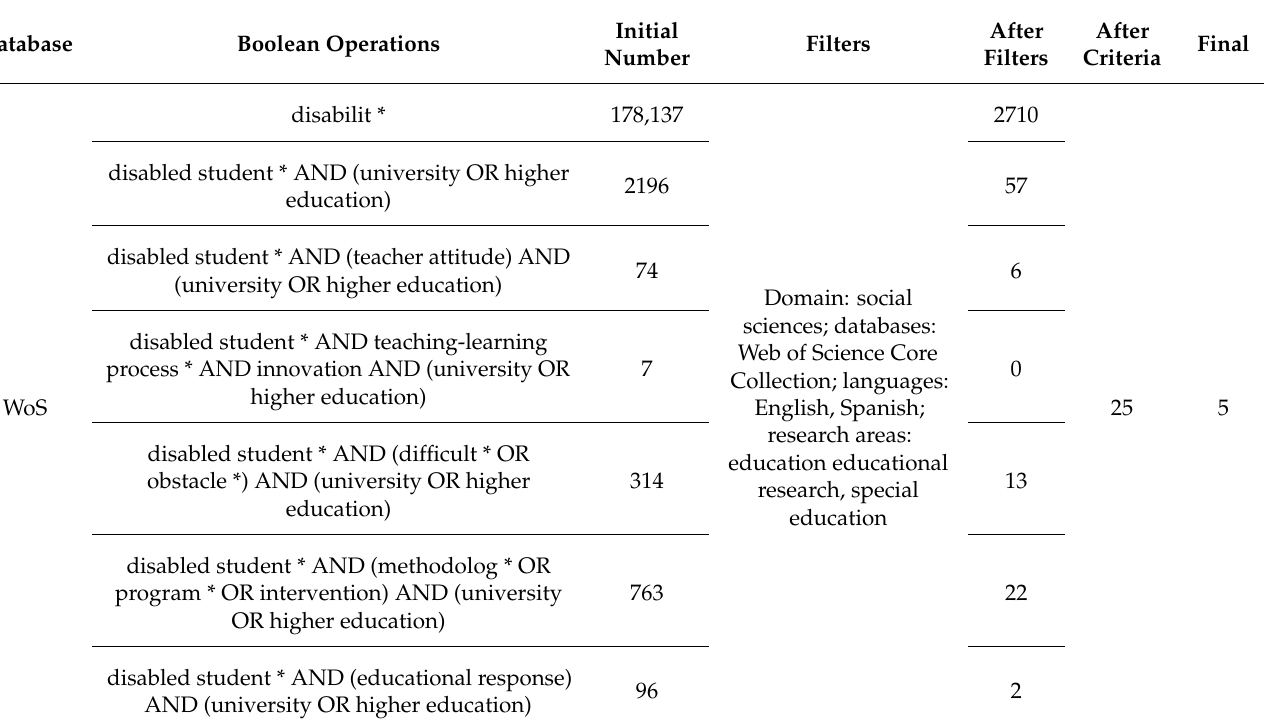
Table 1. Procedure for selecting articles from the structured search in the primary